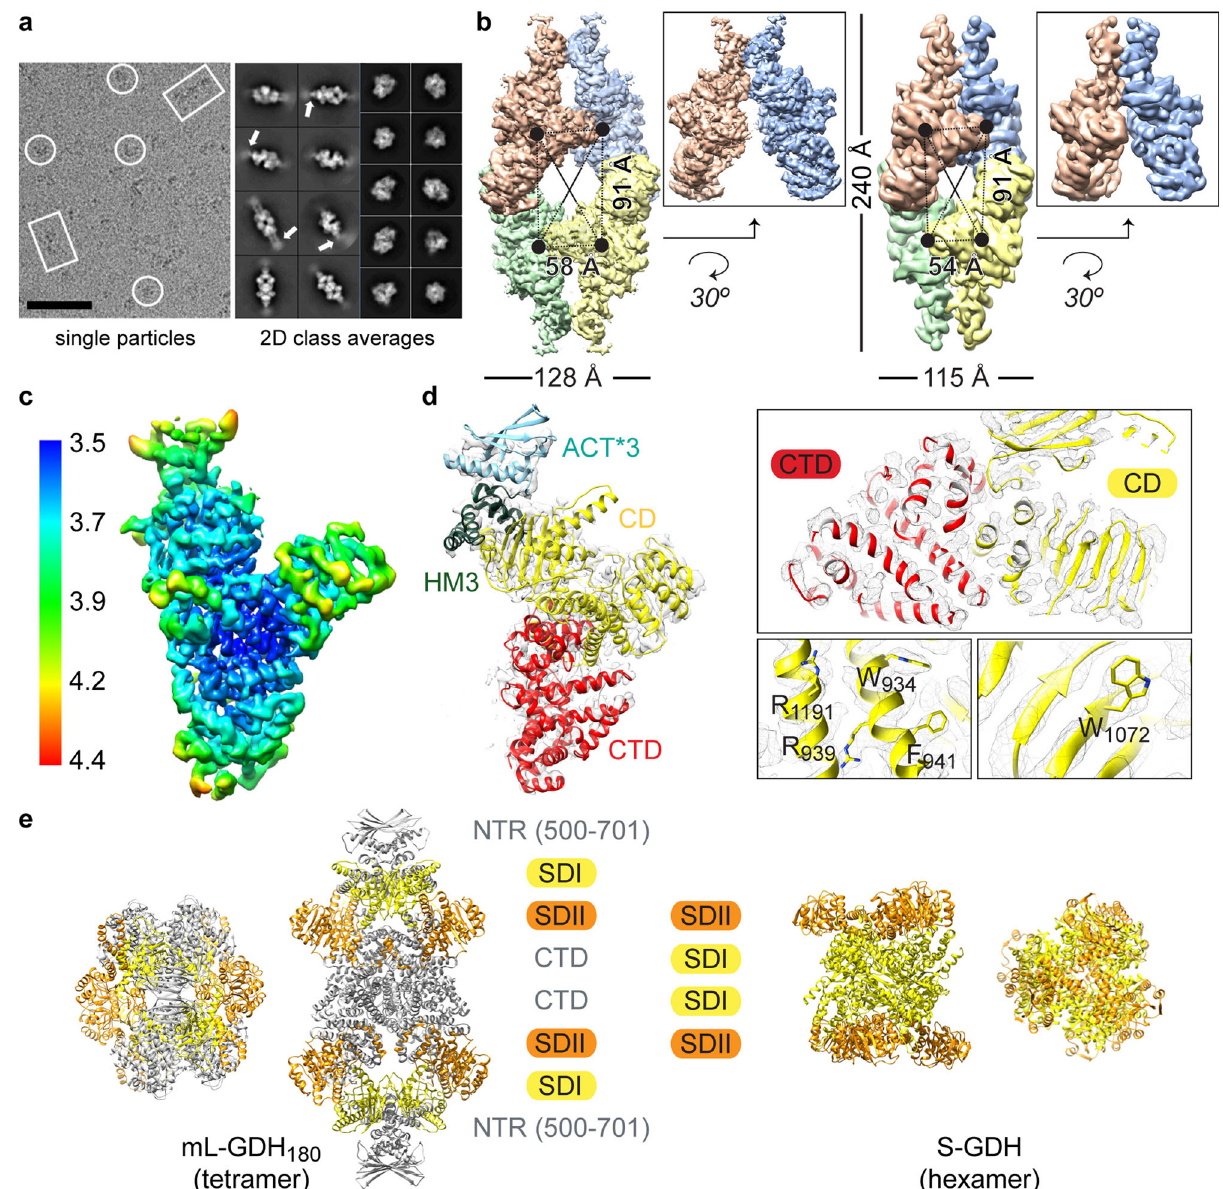
Fig. 2 Intrinsic fl exibility and alternate conformers of native mL-GDH180. a Cryo-EM image obtained for mL-GDH 180 showing side (rectangles) and top (circle) views for single particles. Scale bar: 50 nm. The 2D class averages for mL-GDH 180 tetramers display fl exible ends at side views (white arrows). b Cryo-EM density maps for the open (left, 4.19 Å resolution) and closed (right, 6.6 Å resolution) conformations of mL-GDH 180 tetramers, segmented into the four subunits. Black dots: centers of mass of the subunits. Insets are close-up views of the contact zone between the N-terminal regions (NTRs) of two monomers. c Local resolution for a single subunit of the open conformation after focused re fi nement (average resolution is 3.59 Å). d Cryo-EM map for one mL-GDH 180 subunit and the fi tted atomic coordinates. Domains colors and labels are as in Fig. 1. Insets are close-up views; selected amino acid side chains are shown as sticks. e Comparison of the quaternary structure of mL-GDH 180 , with D2 symmetry, and a representative hexameric S-GDH 50 (PDB code 3SBO), with D3 symmetry. The catalytic domains are colored into SDI (yellow) and SDII (orange). The NTRs (only the portion that is well de fi ned in cryo- EM maps is displayed) and the CTDs of mL-GDH 180 monomers are depicted in gray. See also Supplementary Figs. 3 and